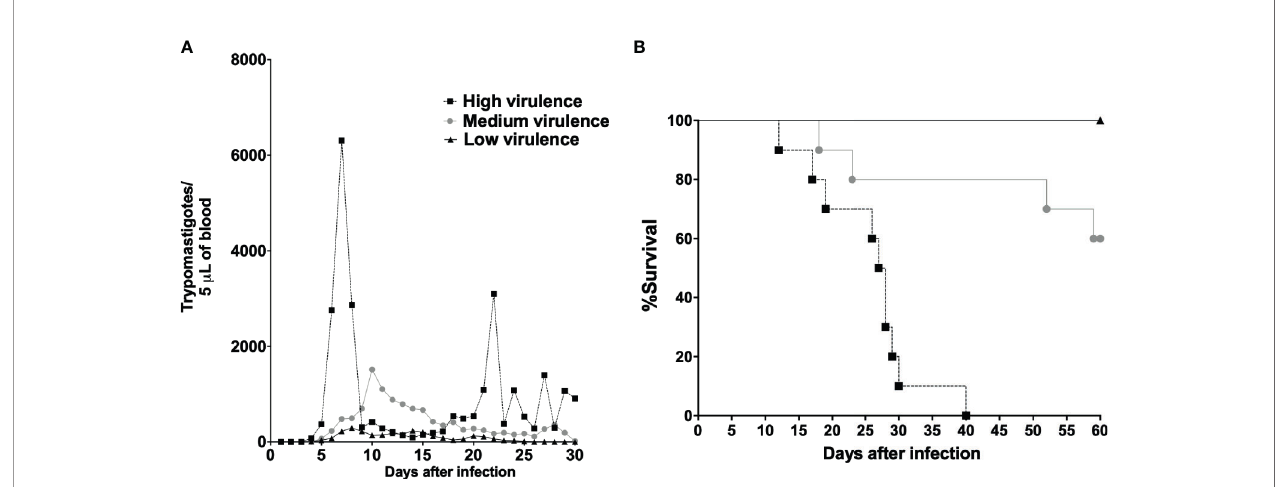
FIGURE 1 | Trypanosoma cruzi were grouped in high, medium, and low virulent strains according to parasitemia and survival in mice. Parasitemia (A) and survival (B) in Swiss mice infected by the intraperitoneal route with 1 × 10 4 blood trypomastigote forms of T. cruzi strains that showed high (Colombian + Y), medium (PL1.10.14/TcIII + CL/TcVI), and low (AM64/TcIV + 3253/TcV) virulence. The data are representative of two independent experiments (n = 10, ten animals were infected with each